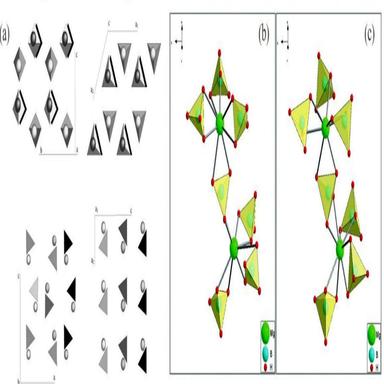
(a) Crystal structure of LiBH4 at room temperature (left) and at 408 K (right) as shown along two orthogonal directions; (b-c) Two structures of eight-fold hydrogen coordination environment of Mg cations.